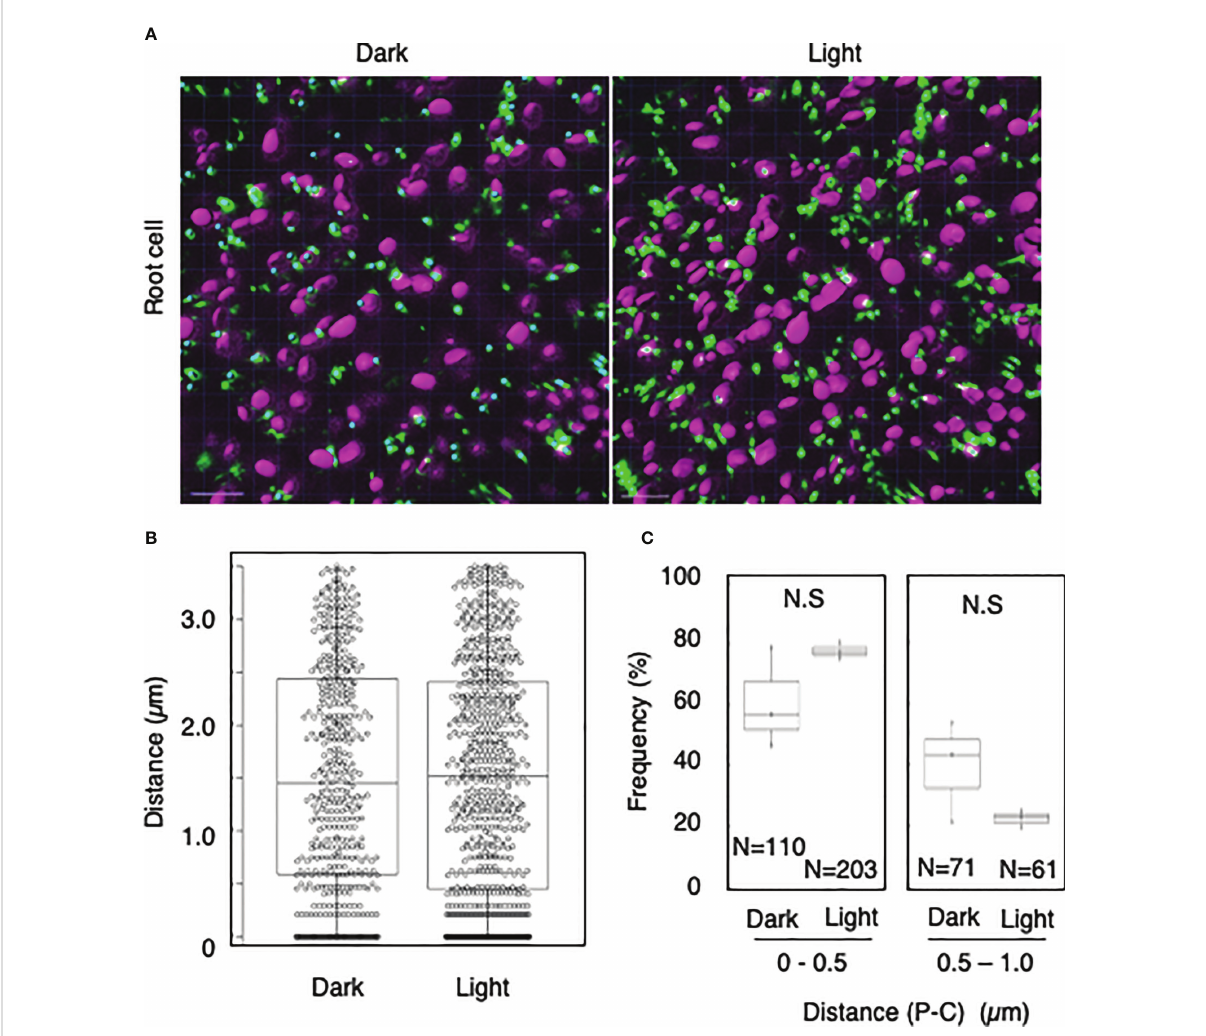
FIGURE 4 Measurement of the distances between chloroplasts and peroxisomes in root cells. (A) Representative images of chloroplasts (magenta) and peroxisomes (green) in greening root cells in the dark (left) and light (right). Bars, 10 µm. (B) Box plots of the distances between peroxisomes and chloroplasts in greening root cells in the dark and light from three image areas. The average distance was 1.52 ± 1.07 µm (n = 483) in the dark and 1.52 ± 1.09 (n = 761) in the light. The median distance was 1.45 µm in the dark and 1.52 µm in the light. (C) Frequency of the distances between peroxisomes and chloroplasts in the dark and light. The frequency of distances of 0.5 – 1.0 µm was 60.7 ± 16.6% (n = 110) in the dark and 77.7 ± 2.9% (n = 203) in the light, whereas the frequency of distances of 0.5 – 1.0 µm was 39.3 ± 16.8% (n = 71) in the dark and 37.7 ± 7.2% (n = 61) in the light in (B) . N.S indicates no signi fi cant difference between the dark and